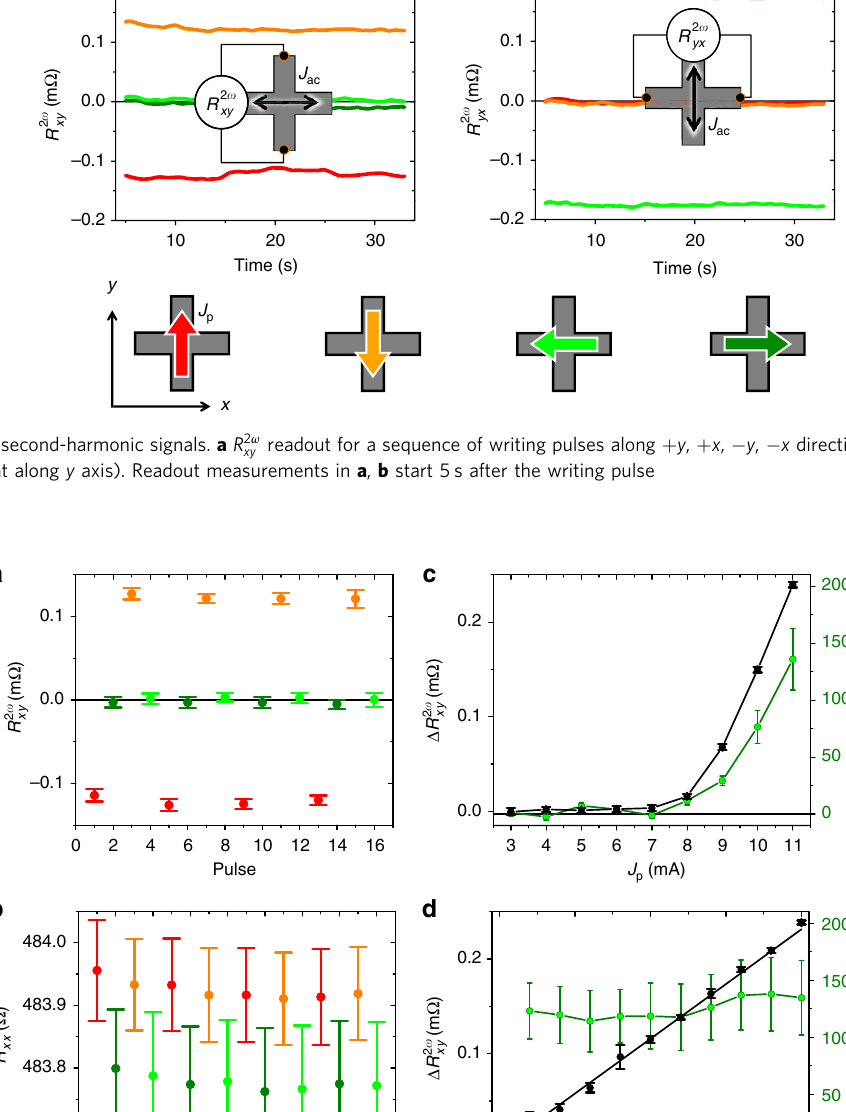
device sketches in the fi gure. In Fig. 3a, the probing current is , we can now detect the reversal y direction and measuring R 2 ω yx along the x axis and R 2 ω between the Néel vector states set along the y axis (by writing can only detect the reversal between Néel xy current pulses along the x axis). Consistently, the reversal of the vectors set along the x axis by writing current pulses along the y is negligible for states antiferromagnetic order between states set along the x axis (by axis (red/orange). On the other hand, R 2 ω xy , as with Néel vectors set along the y axis by writing current pulses writing current pulses along the y axis) is not detectable by R 2 ω yx also seen in Fig. 3b. along the x axis (dark/light green). To highlight that it is indeed the second-order magnetoresistance probing that is not effective in this geometry and not an inability in our material to set the Néel vector along the y axis, we rotate the detection set-up in Fig. 3b by 90°. When sending the probing current in the